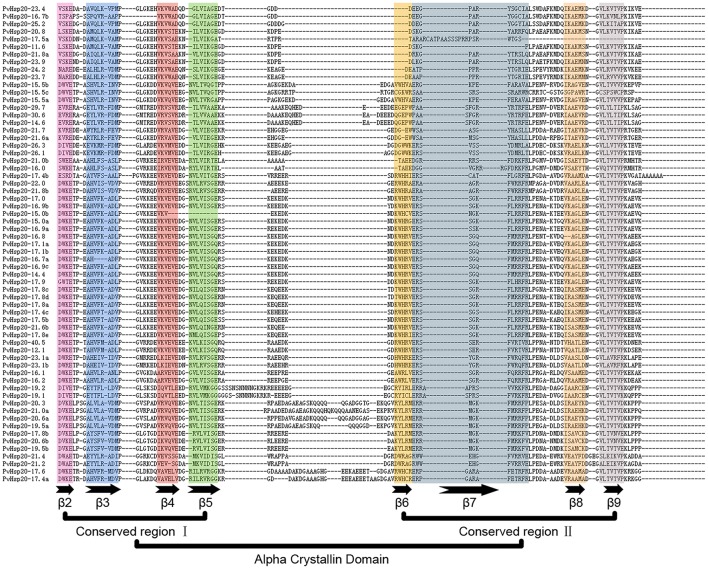
The alignment of ACDs of sHsps in switchgrass. The names of all members were shown in the left side of figure. Each predicted β-plated sheet is shown for different color backgrounds. β2, β3, β4, and β5 were included in conserved region I (CRI), while β6, β7, β8, and β9 were included in conserved region II (CRII).